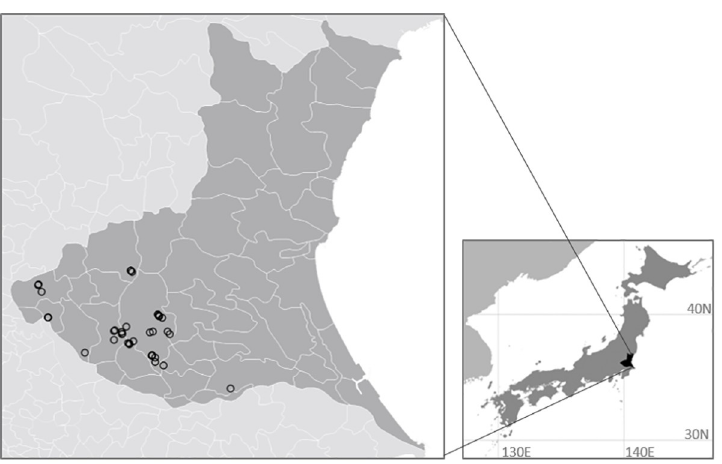
Fig 1. Locations of the 41 study sites in Ibaraki Prefecture, Japan. Points were converted into 1-km 2 grid data.